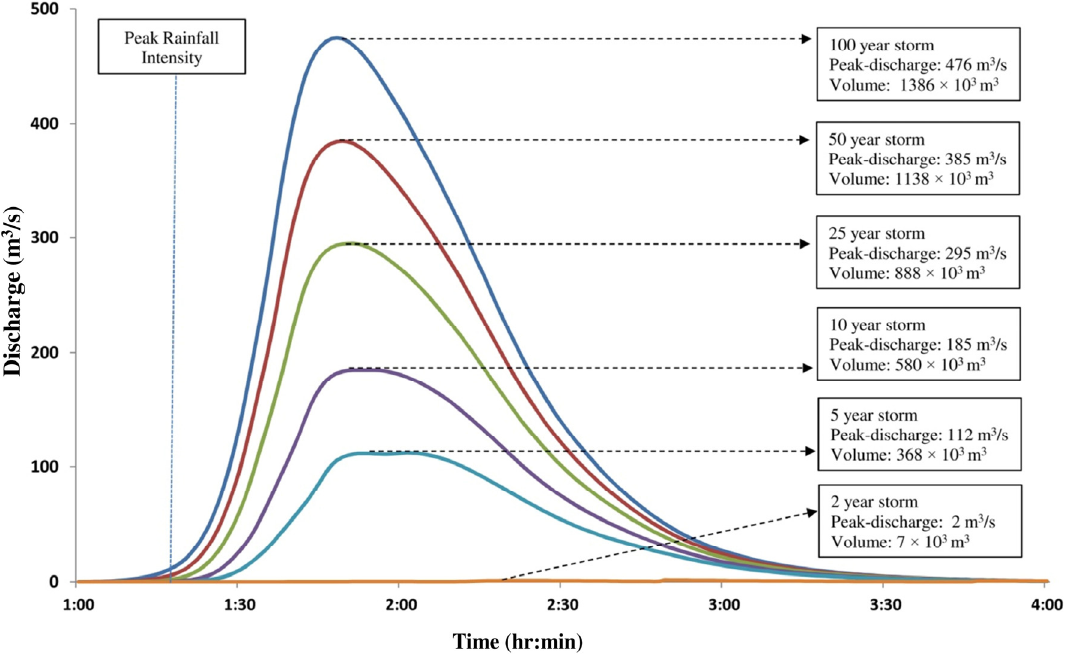
Figure 15. Flood hydrographs with ARIs of two to 100 years (Ravine Lan